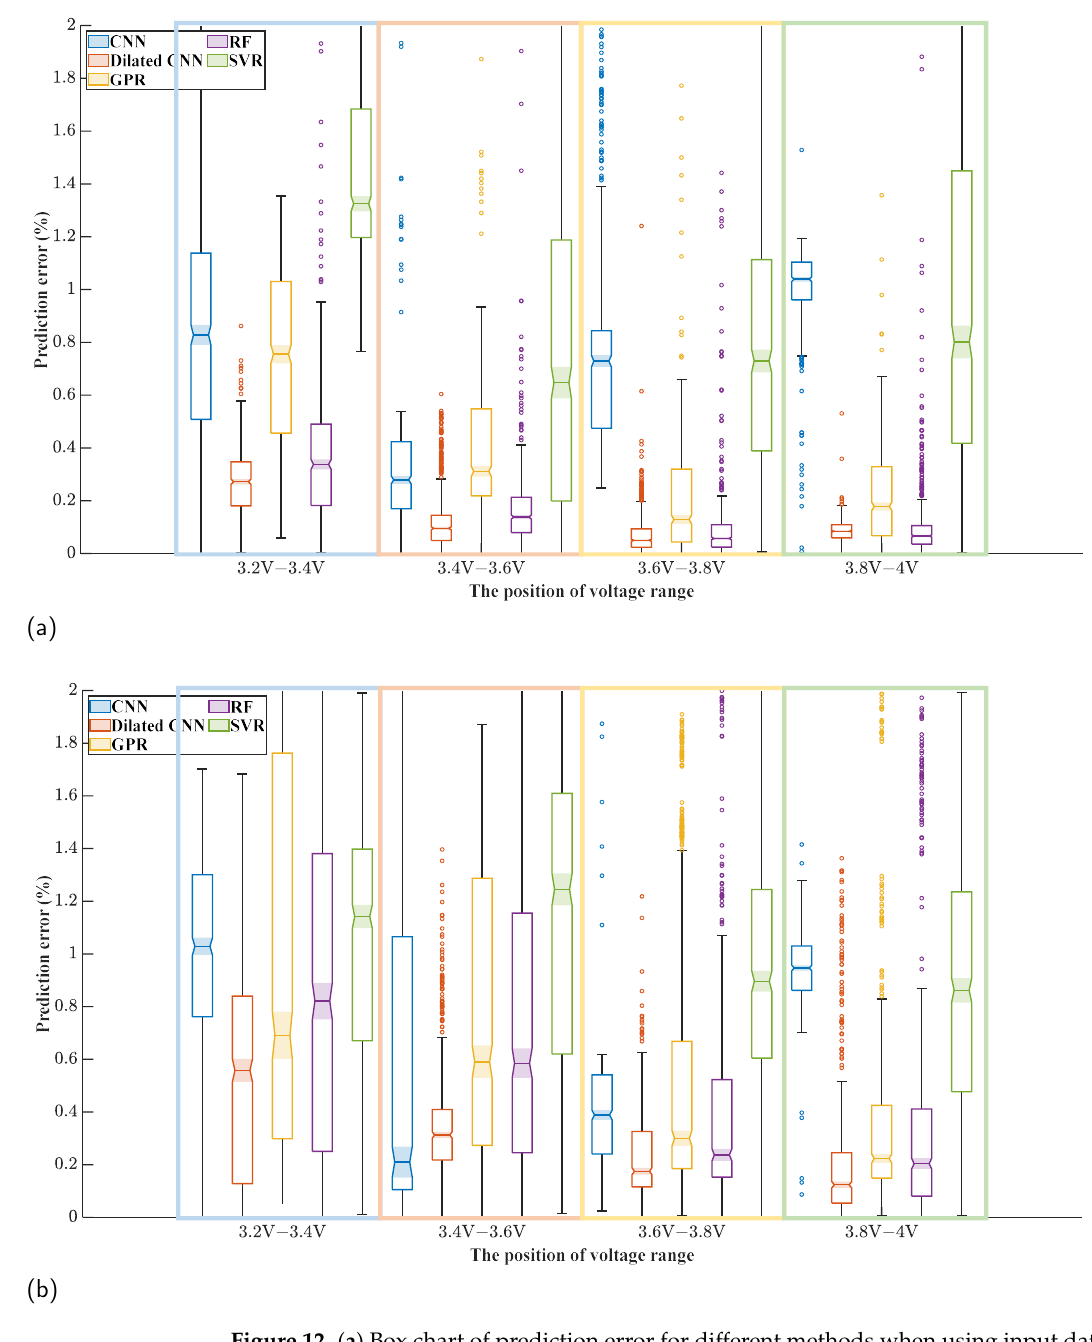
Figure 12. ( a ) Box chart of prediction error for different methods when using input data of voltage range at different positions with Cell 02 as the test set. ( b ) Box chart of prediction error for different methods when using input data of voltage range at different positions with Cell 04 as the test